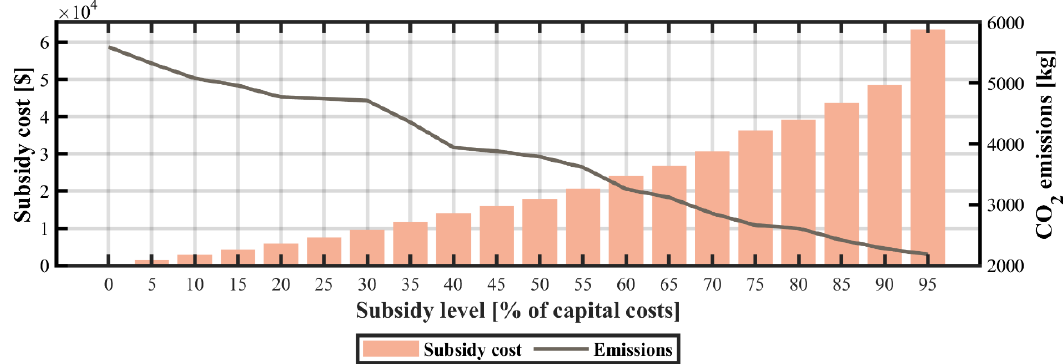
Figure 13. Simulation results of capital subsidies for PV technologies. Impact on subsidy costs and CO 2 emission levels. CO 2 emission levels.